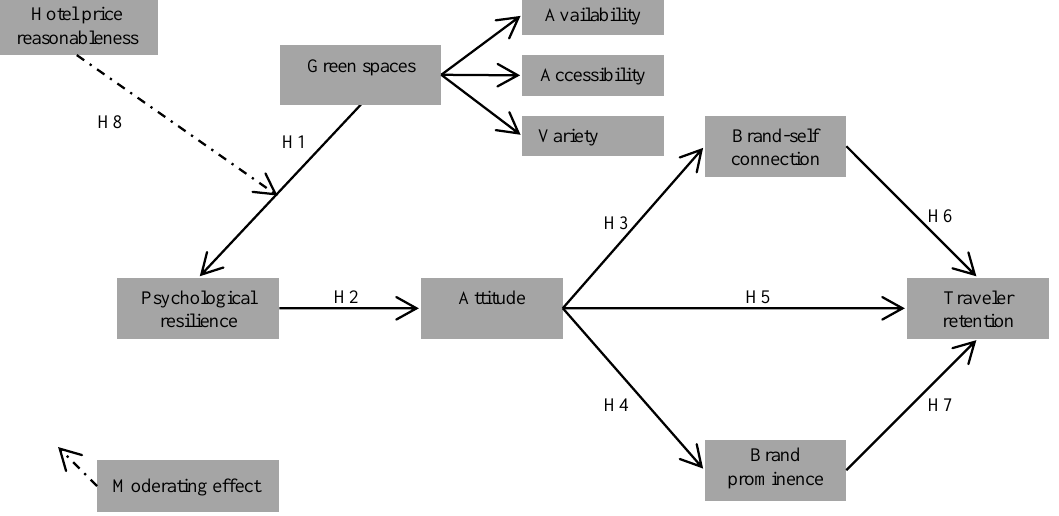
Figure 1. Proposed conceptual model and research hypotheses.